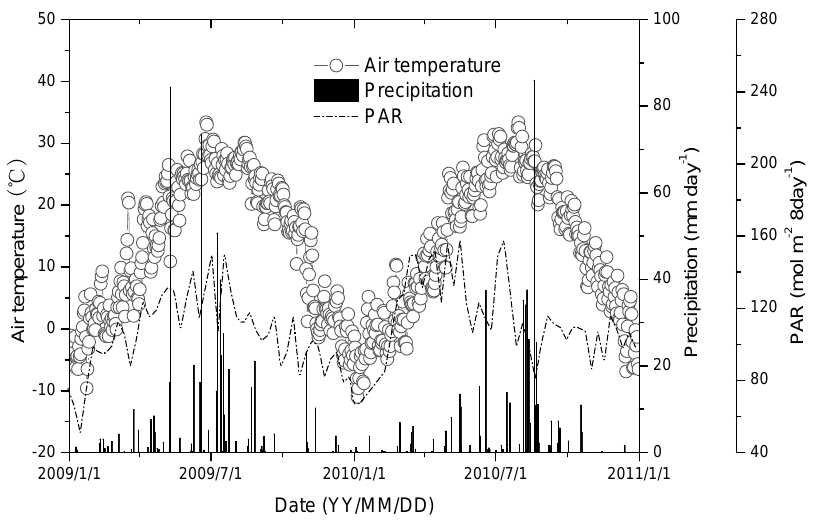
Figure 3. Seasonal variation in daily air temperature, precipitation, and aggregated eight-day PAR from eddy covariance (EC) tower during 2009–2010.